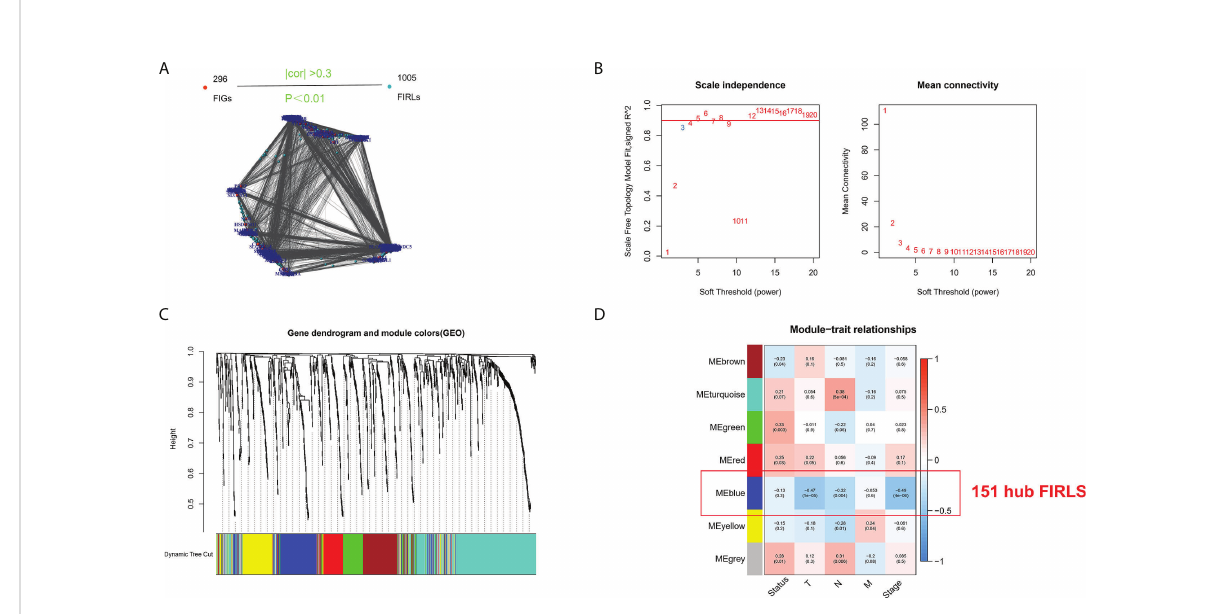
FIGURE 1 Screening of survival-related lncRNAs by WGCNA. (A) Identi fi cation of FIRLs using Pearson correlation analysis. (B) Soft power in WGCNA. (C) Clustering and merging of the co-expression modules. (D) Association heatmap of module genes and clinical features. Red means positive association, and blue refers to negative association. Correlation grows as the color